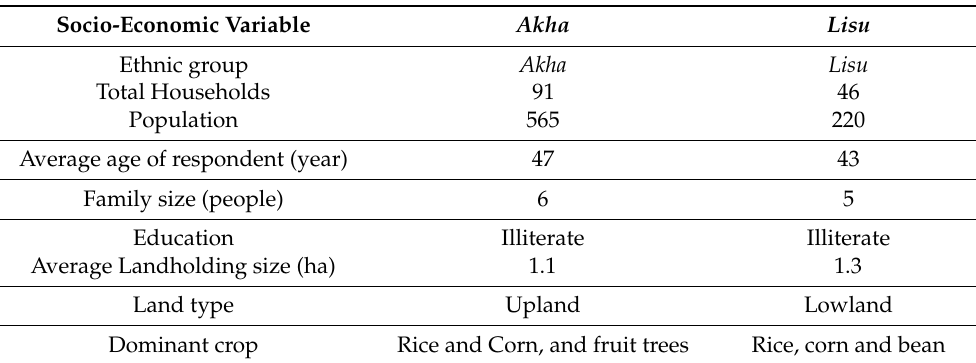
Table 1. Socioeconomic characteristics of each